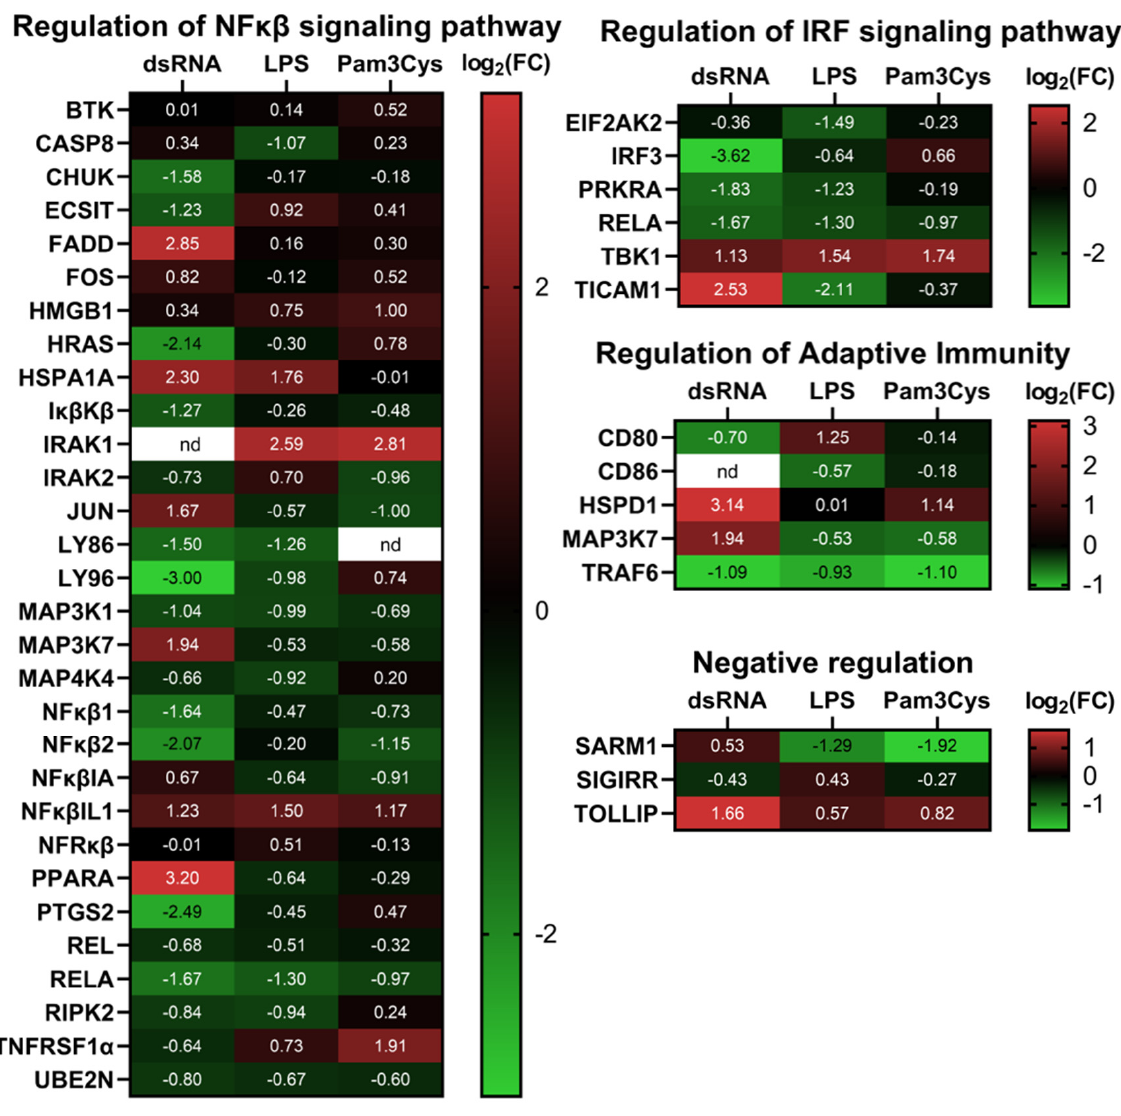
Figure 3. Heatmap depicting differential expression of genes involved in regulation of NFk β and IRF signaling pathway, regulation of adaptive immunity, and negative regulation in challenged TLR10 OE cells. Data represent a pool of 3 biological replicates. Red color, upregulation of gene expression; green color, downregulation of gene expression; nd = not detected.